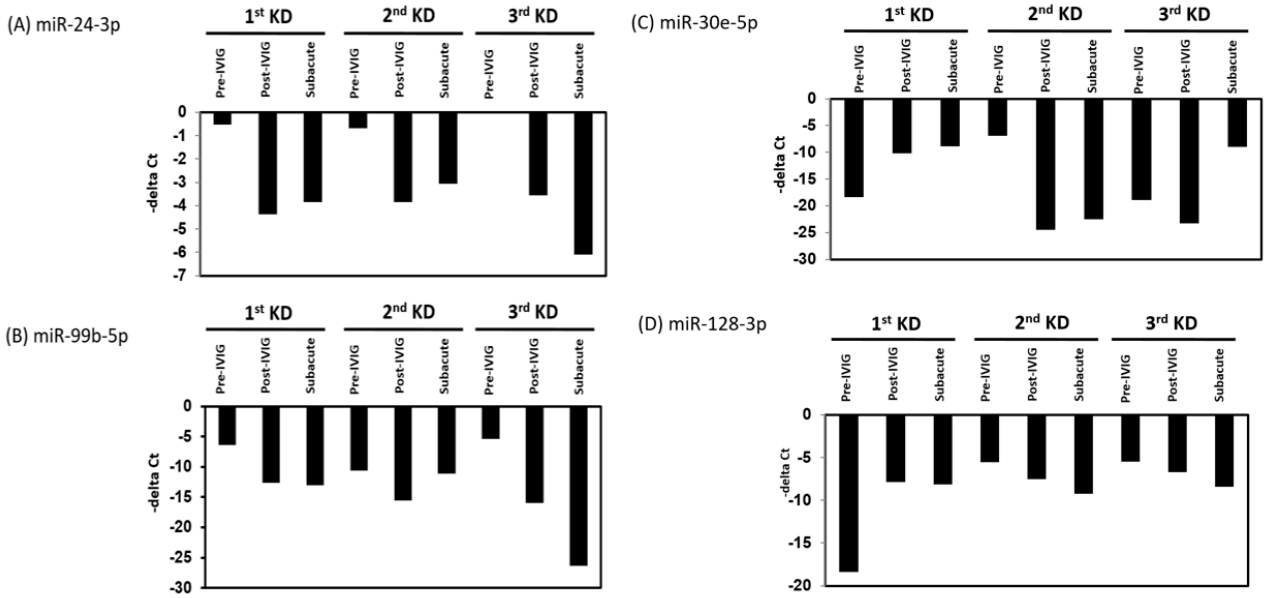
Figure 5. Expression levels of miR-24-3p, miR-99b-5p, miR-30e-5p, and miR-128-3p in patients with recurrent KD. The relative levels of miR-24-3p ( A ), miR-99b-5p ( B ), miR-30e-5p ( C ), and miR-128-3p ( D ) were examined in plasma from patients with KD, and those relapsed with second and third times at different stages using the TaqMan real-time polymerase chain reaction (PCR). miR-16 was used as an internal control to normalize the expression levels of miRNA candidates (deltaCt miRNA candidates = Ct miRNA candidates − Ct miR-16 ).